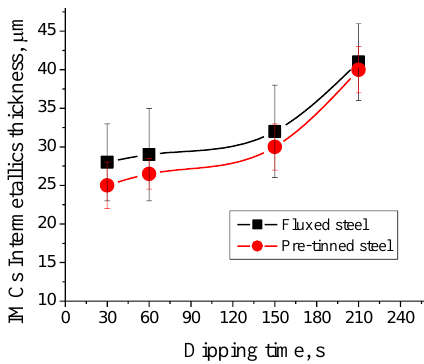
Figure 5. Effect of dipping time on thickness of Fe–Sn IMC interface coatings fluxed and pre- tinned steel.